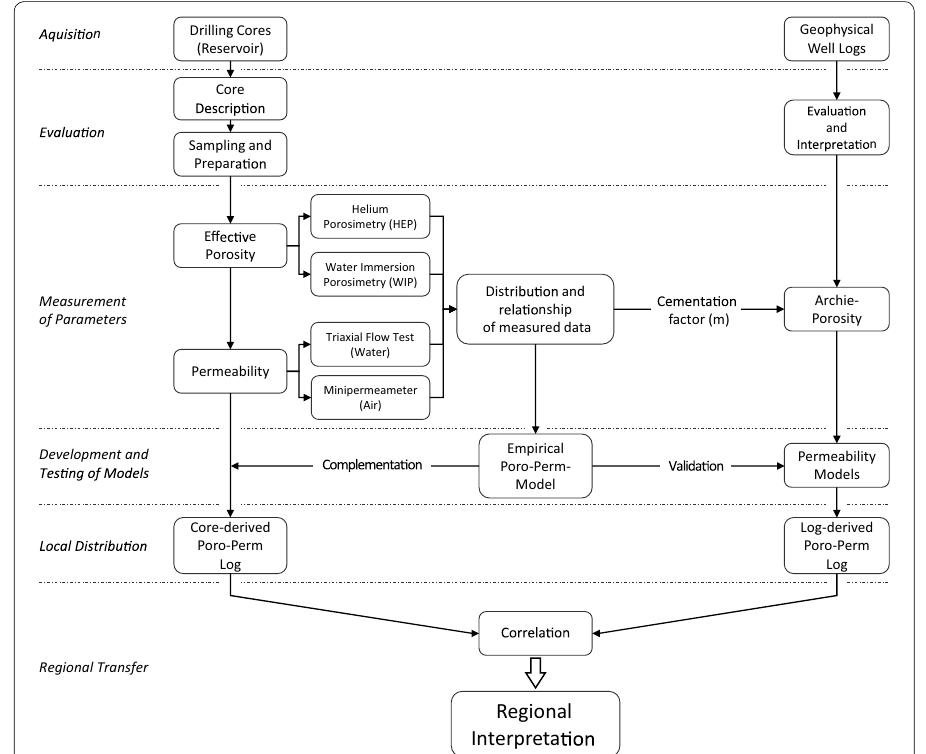
Fig. 2 Workflow for determination of hydraulic parameters from drilling cores and downhole logs